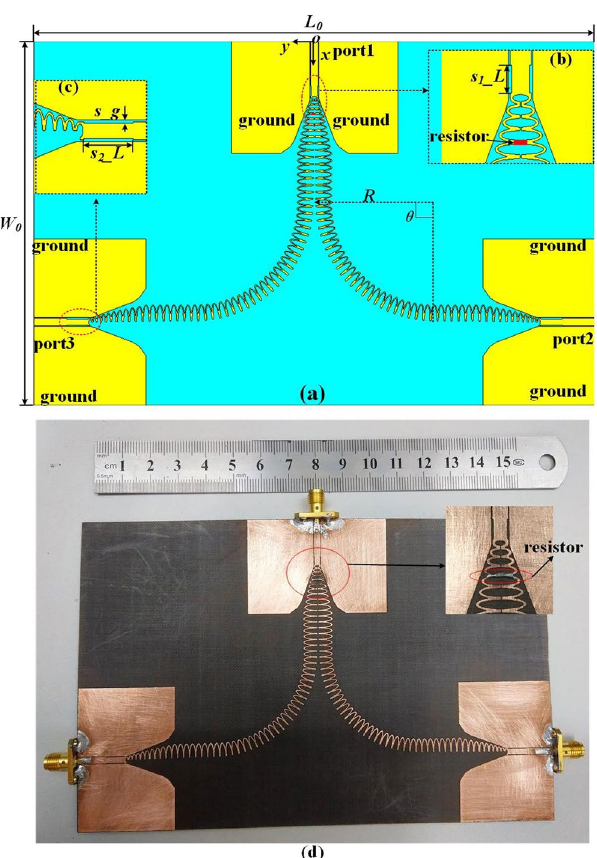
Figure 5. The configuration of the proposed power divider. ( a ) The schematic of power divider, in which L 0 = 169 mm, W 0 = 109.5 mm, the rotation angle of half oval-rings θ = 90°, and R = 36 mm. ( b ) The stepped impedance of port 2, in which s 2 _L = 6.5 mm and s_g = 0.2 mm. ( c ) The stepped impedance of port 1, in which s1_L = 3 mm. And the small red rectangle in the middle between the fourth half oval-ring structures is a 200 Ω resistor. ( d ) Photograph of the power divider. The detail part with a chip resistor is